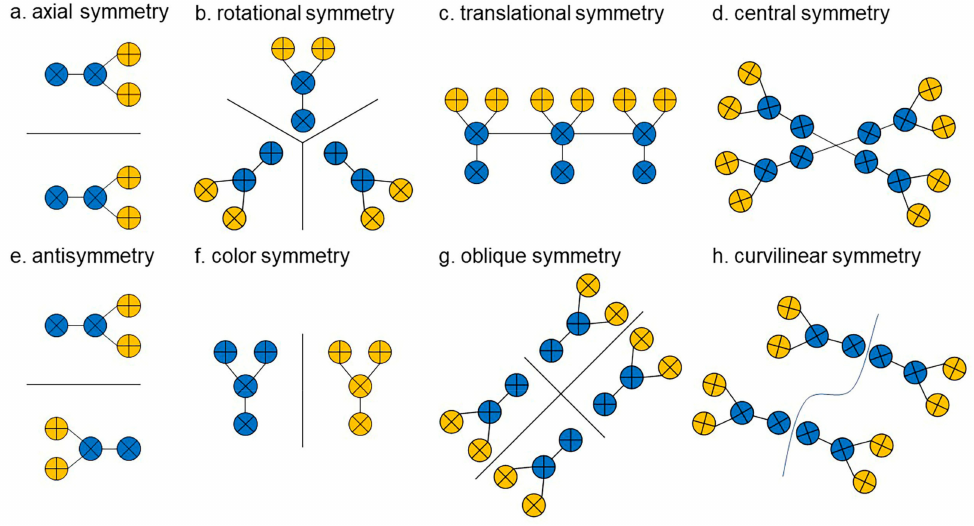
Figure 10. Generalized symmetric structure Tupu. Parts ( a – h ) represent 8 kinds of symmetrical